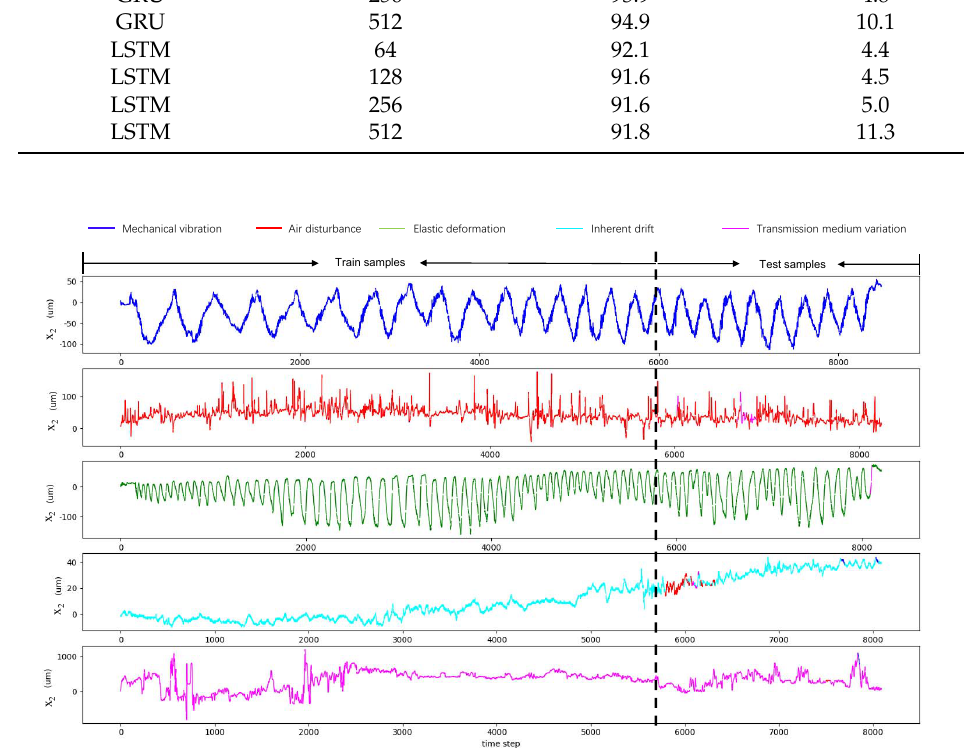
Figure 7. The visualization of the disturbance type classification results of GRU − 512. The five rows show the time series under the five different disturbance types, respectively. The dashed line indicates that each time series is divided into a training part and a testing part. The five colors correspond to the five disturbance types. There exists a color inconstancy in the testing part because of the classification